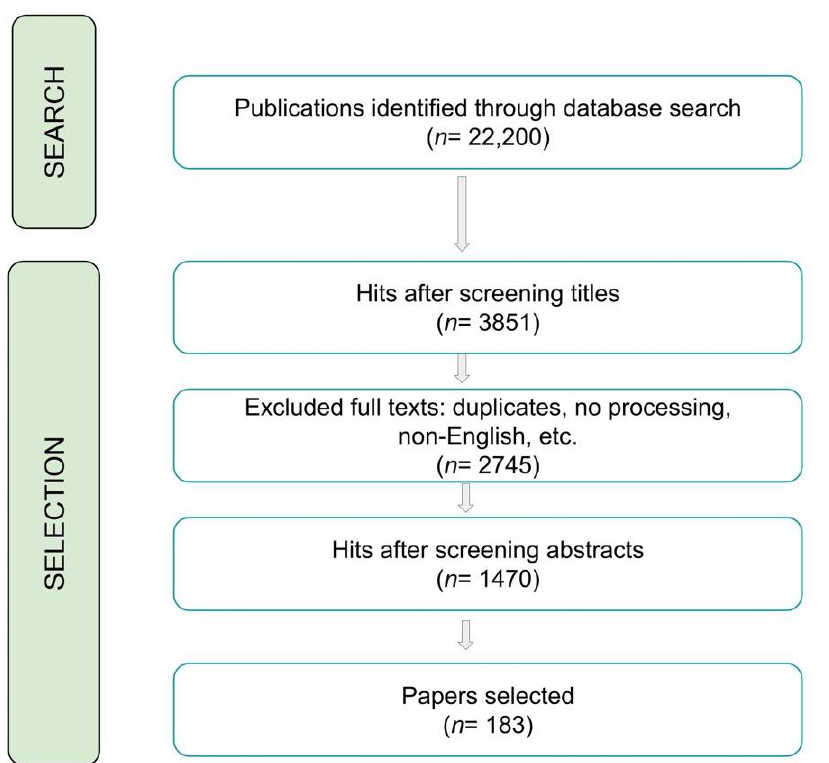
Figure 3. Papers selection process.